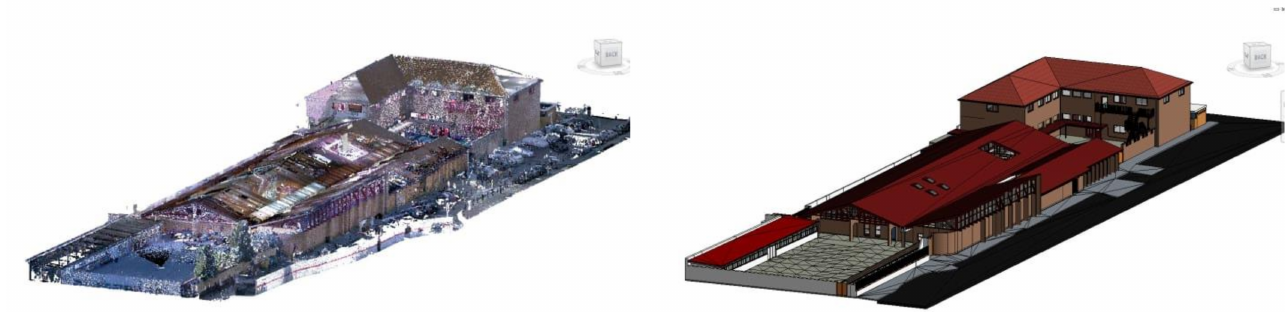
Figure 3. Point Cloud to Revit BIM